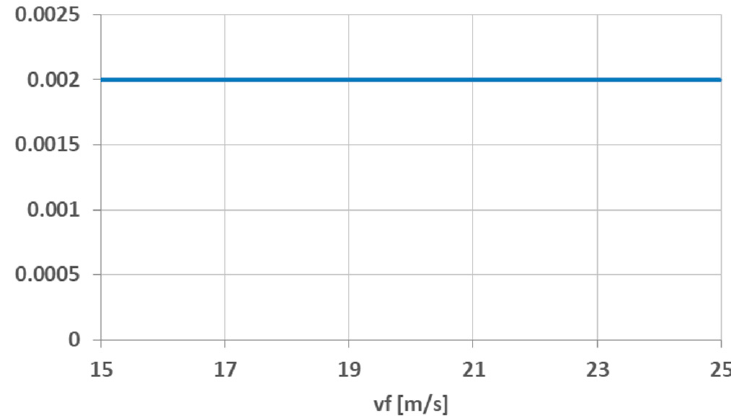
Figure 12. Uniform distribution for the chimney exit flow velocity.